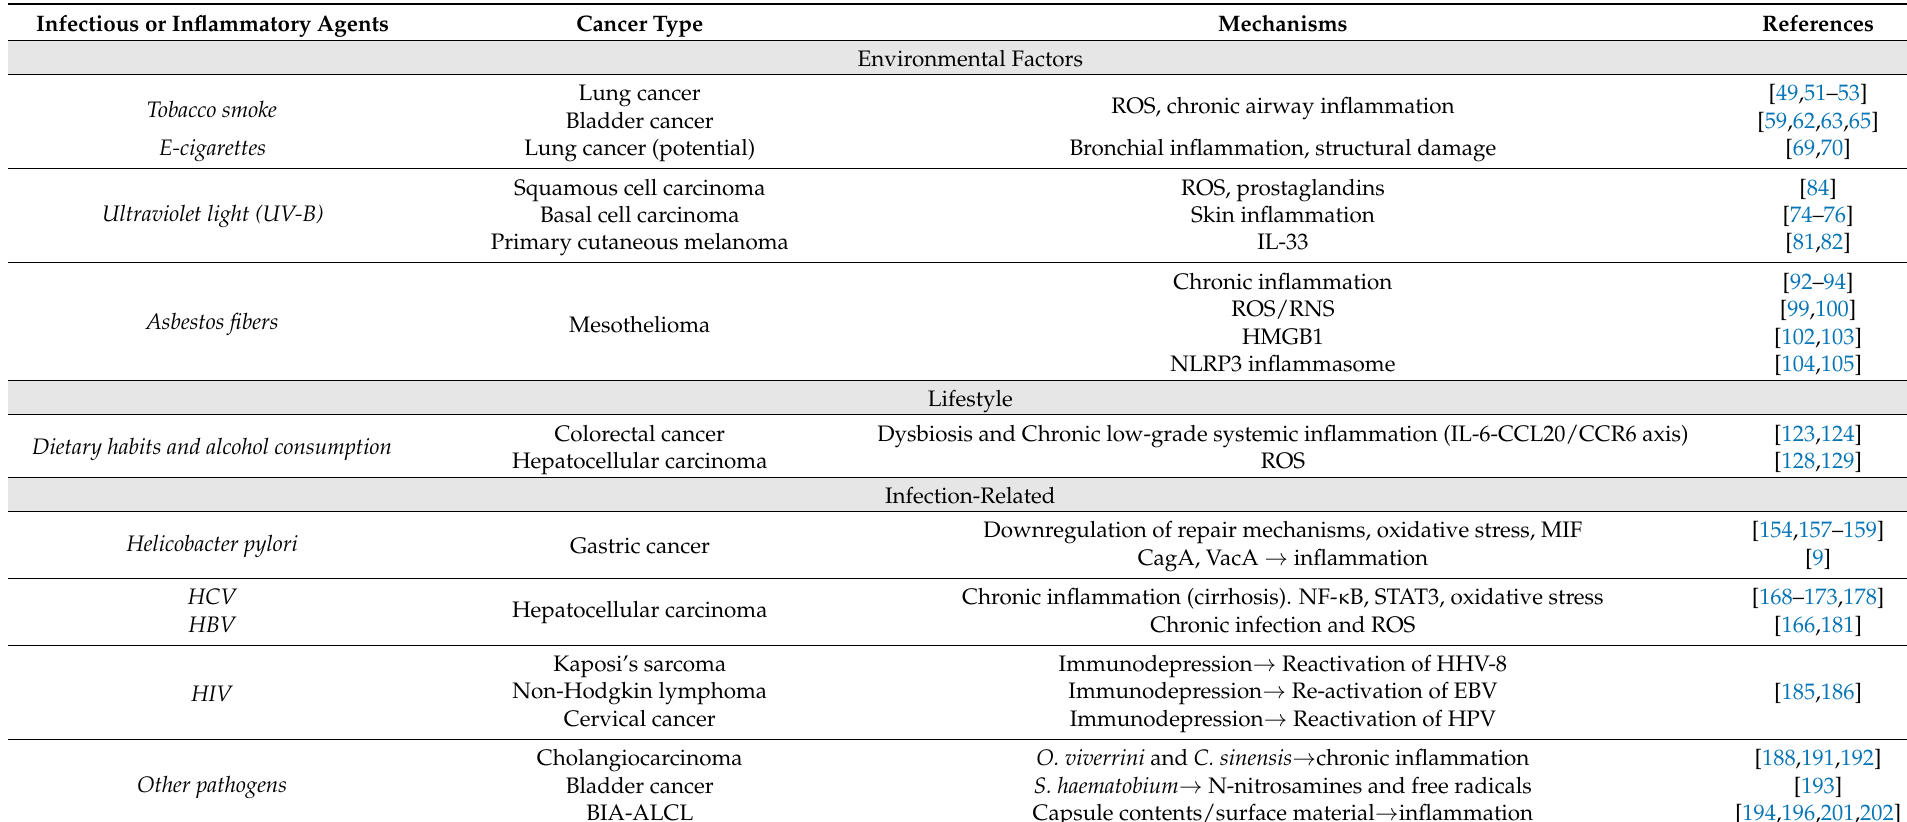
Table 1. Chronic inflammation is associated with different tumor